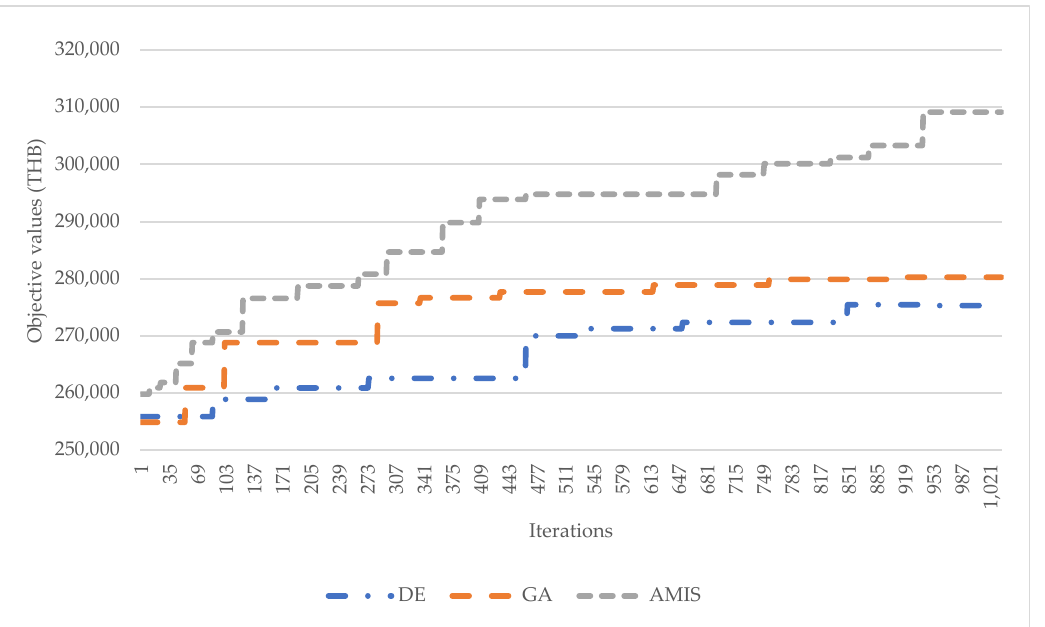
Figure 4. Behavior of the proposed method.